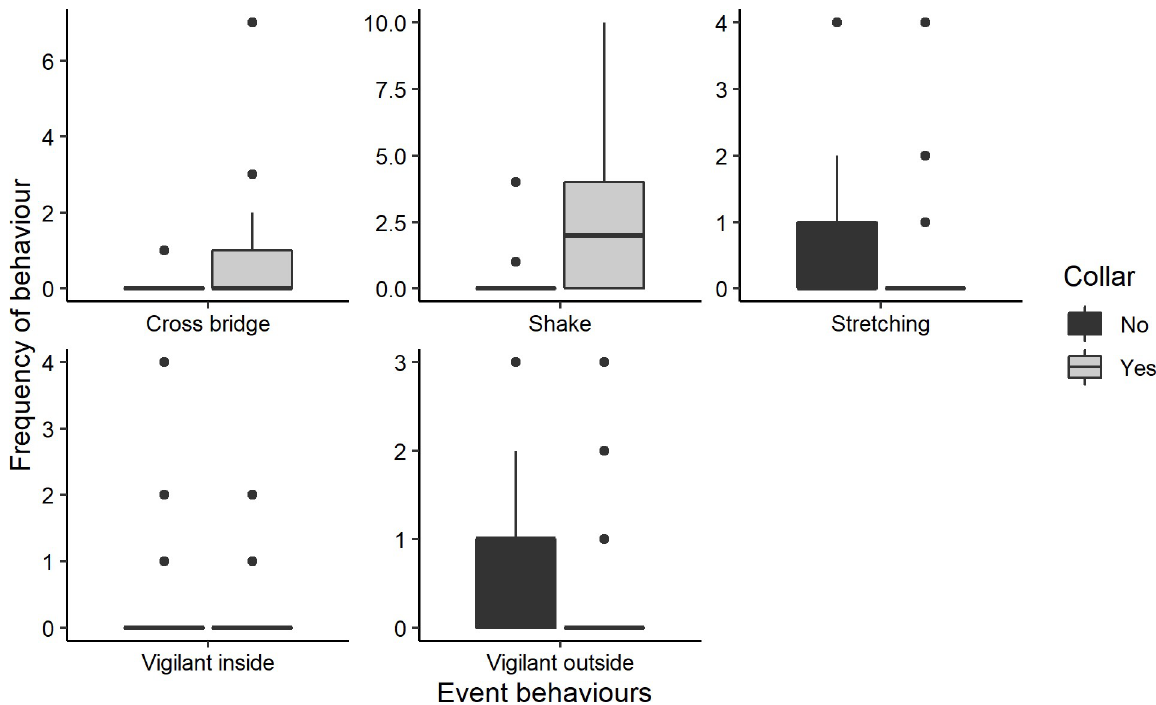
Fig 7. Significant differences between the frequency with which event behaviours were displayed between the collared and uncollared period. Data for the male and female are pooled, only those behaviours that were displayed by both the male and the female are shown. Vigilant inside = vigilant towards something inside the enclosure, Vigilant outside = vigilant towards something outside the enclosure.